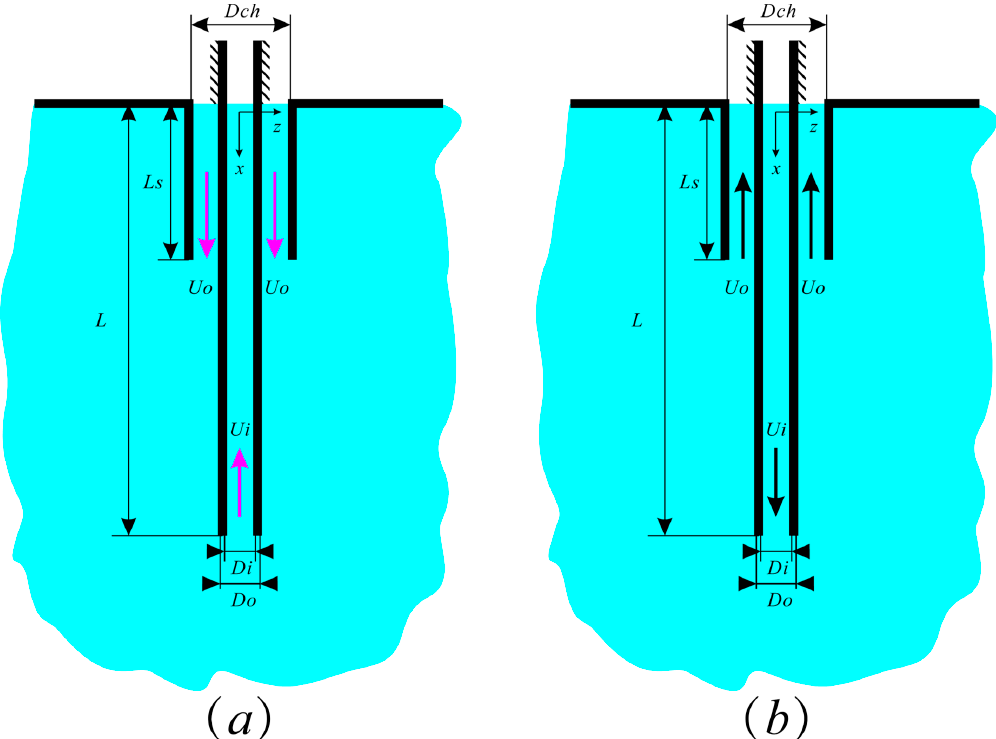
Figure 1. Schematic view of the pipe configuration. A hanging flexible cantilevered pipe conveying fluid is partially confined inside a shorter inflexible external pipe. ( a ) the system considered in this paper; ( b ) the system considered in [1].